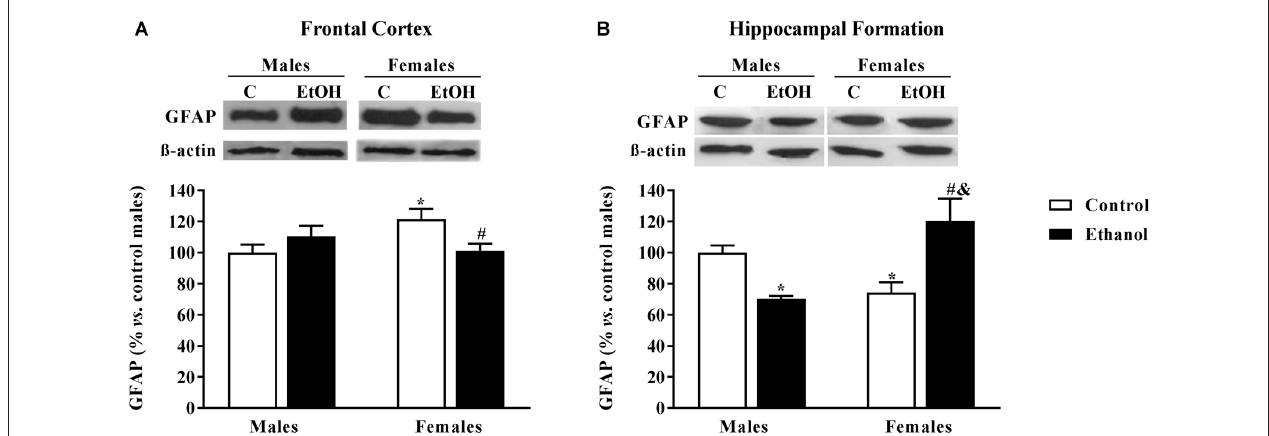
FIGURE 4 | Glial Fibrillary Acid Protein ( GFAP ) expression, as an astrocyte marker. Protein expression levels within the (A) frontal cortex (FC) and (B) Hippocampal formation (HF) of adult male and female rats that were exposed to a ethanol (20% in drinking water) or tap water for 2-h sessions during 3 days and for an additional 4-h session on the 4th day, every week during adolescence, from pnd 28–52. Histograms (mean ± SEM) represent the protein levels expressed as values of optical density calculated as changes from the control male group (%); representative western blotting bands are presented above each histogram. ANOVA, * p < 0.05 vs. control male; # p < 0.05 vs. control female; & p < 0.05 vs. alcohol male. n = 6 per experimental group, coming from four litters.